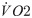
V˙O2 and propulsive force vs distance for the 2100 meters race.V˙O2 (left in green) and propulsive force (right): blue is the propulsive force f(s) in the direction of movement, black is the effective propulsive force ftot=f2+c2v4 taking into account the centrifugal force, where c is the curvature.